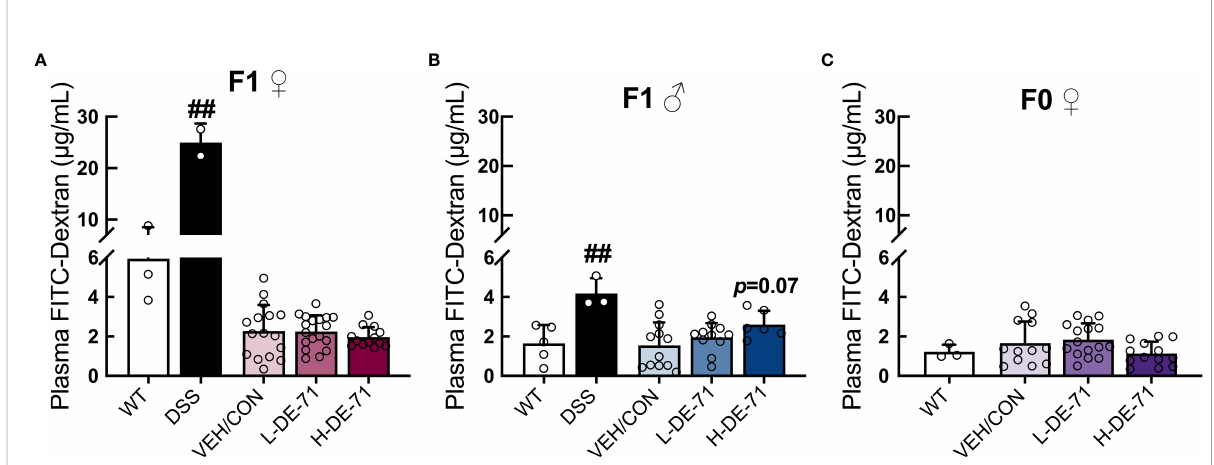
FIGURE 5 Gut barrier permeability in DE-71 exposed dams and offspring. Mice were fasted 14 h before gavage with 60mg/kg of 4 kDa FITC-dextran and serum samples collected 4 h later were read for fl uorescence intensity at 490 nm using a Promega GloMax spectrometer. (A – C) Plasma FITC levels in exposed and VEH/CON groups. Bars and error bars represent mean±s.e.m. Exposure had no main effect as indicated by One-way ANOVA. DSS treatment was used as a positive control; ## signi fi cantly different compared to VEH/CON, p <0.01, Student ’ s t-test. Sample size (n/ group): (A) female offspring 2-16. (B) male offspring: 3-12. (C) dams